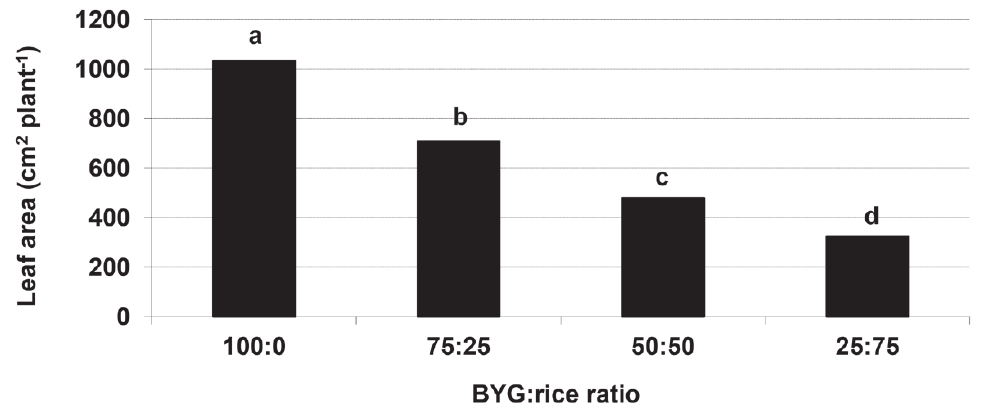
Figure 1 - Effect of barnyardgrass (BYG):rice ratio on leaf area of BYG.